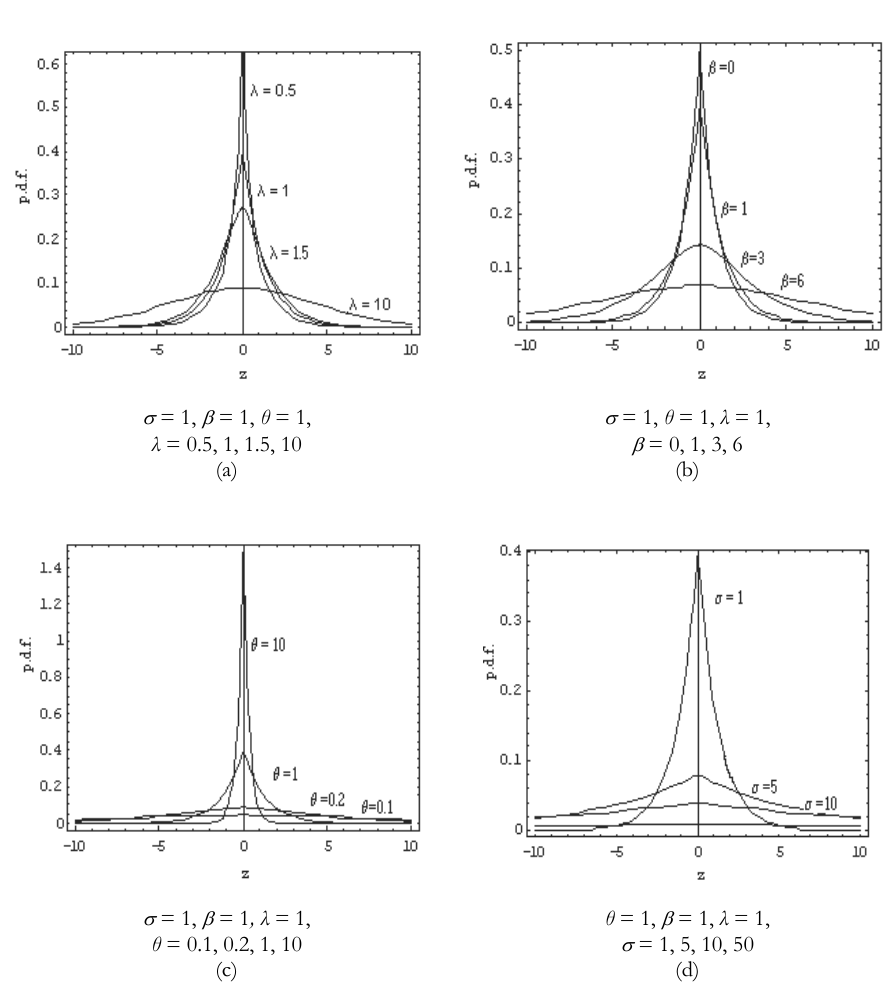
Fig. 1 – Different possible shapes of the p.d.f. (23) for specified values of parameters λ ,  , θ and 